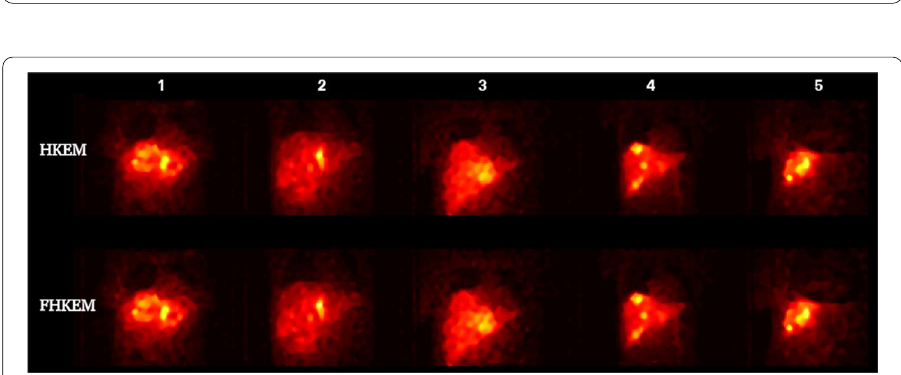
Fig. 11 HKEM and FHKEM Images at the optimum Mean‑CoV point for all the 5